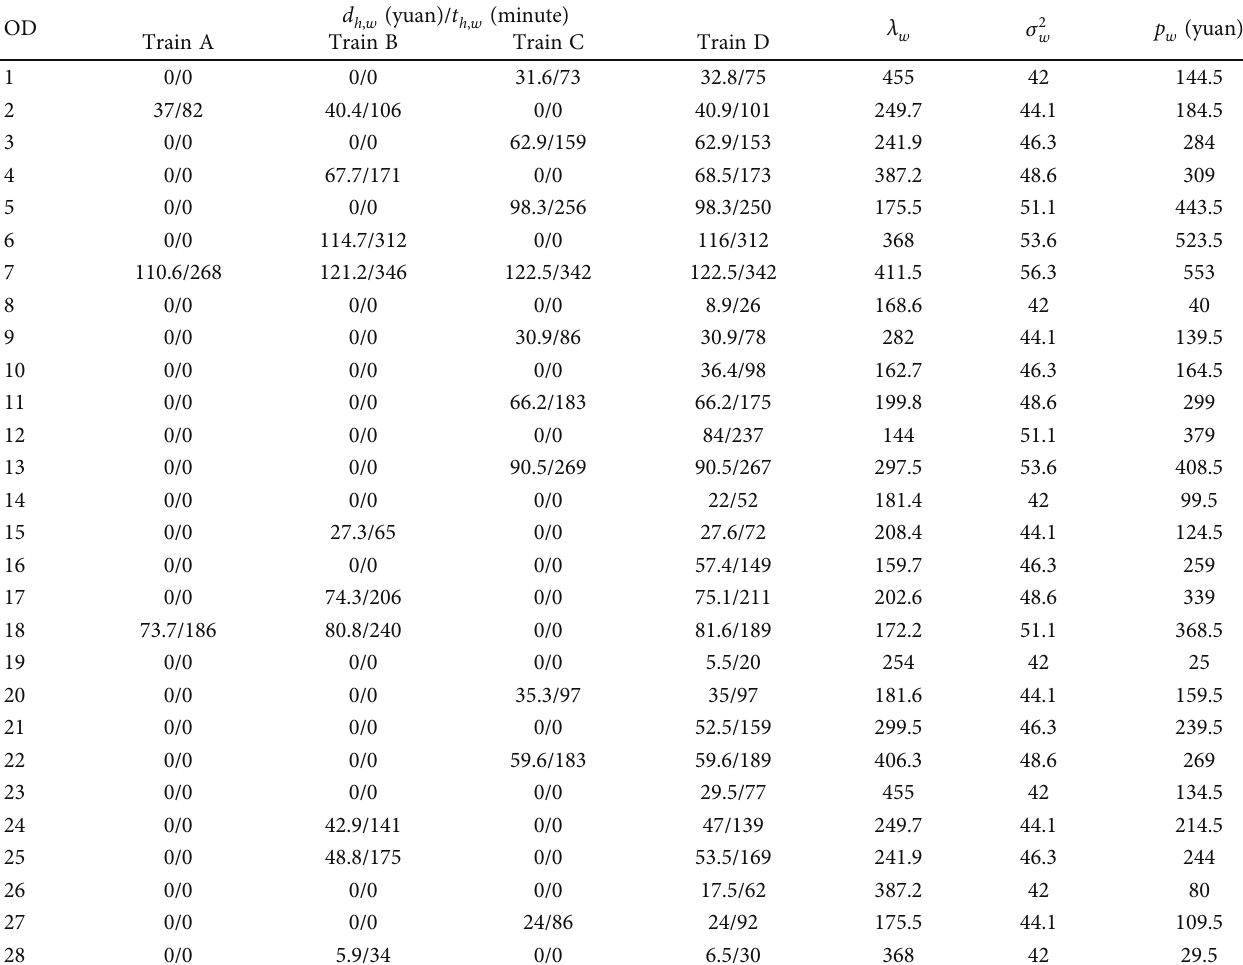
, t , p , average demand λ h , w h , w w